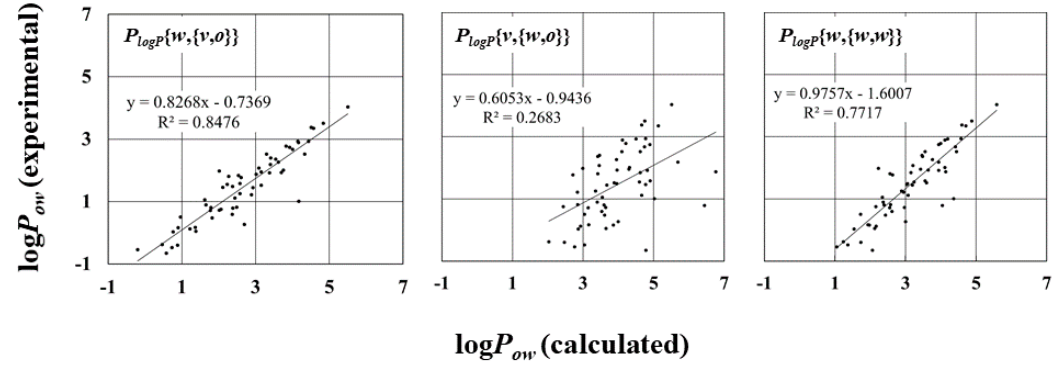
Figure 4. Scatter diagram of calculated and experimentally measured log P ow values. The diagrams with the largest and smallest R 2 are shown, and the diagram of P logP { w, { w, w }} are shown for reference. R 2 and regression line are shown.